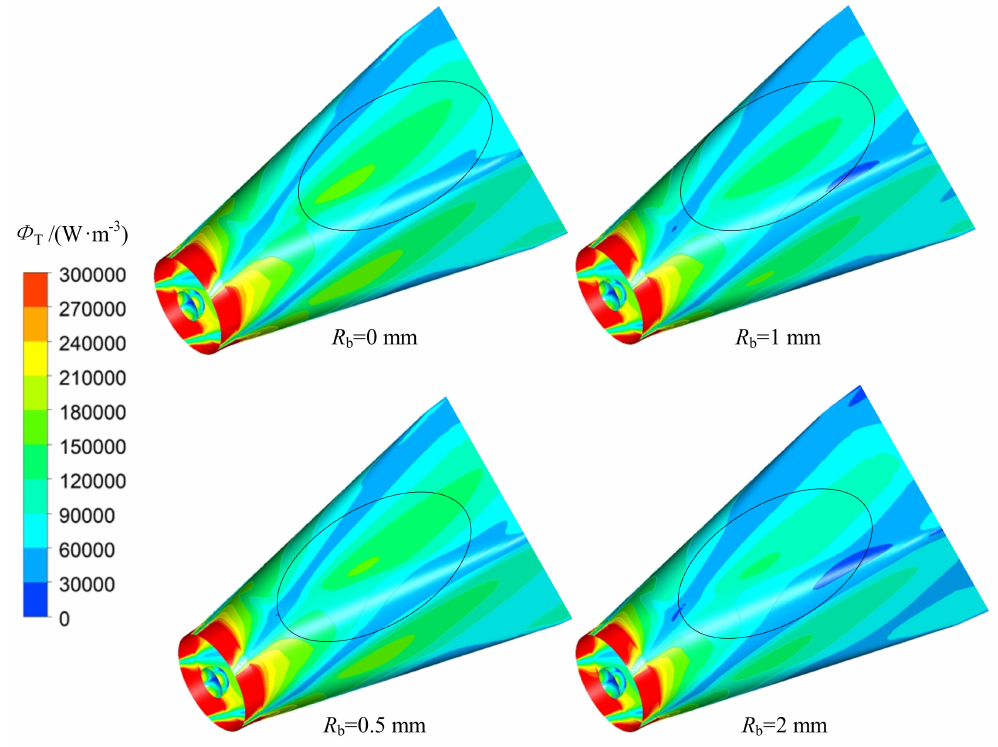
Figure 18. Distribution of total dissipation rate on the outlet passage wall under different R b at Q = 1.0 Q des